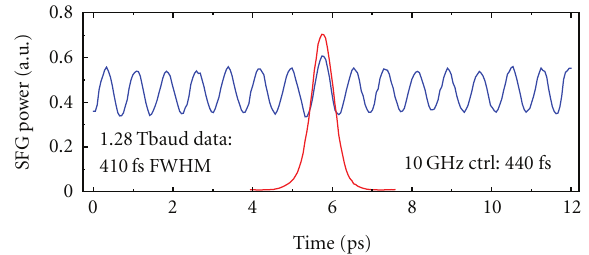
Figure 14: 1.28 Tbaud data pulses with DQPSK modulation.